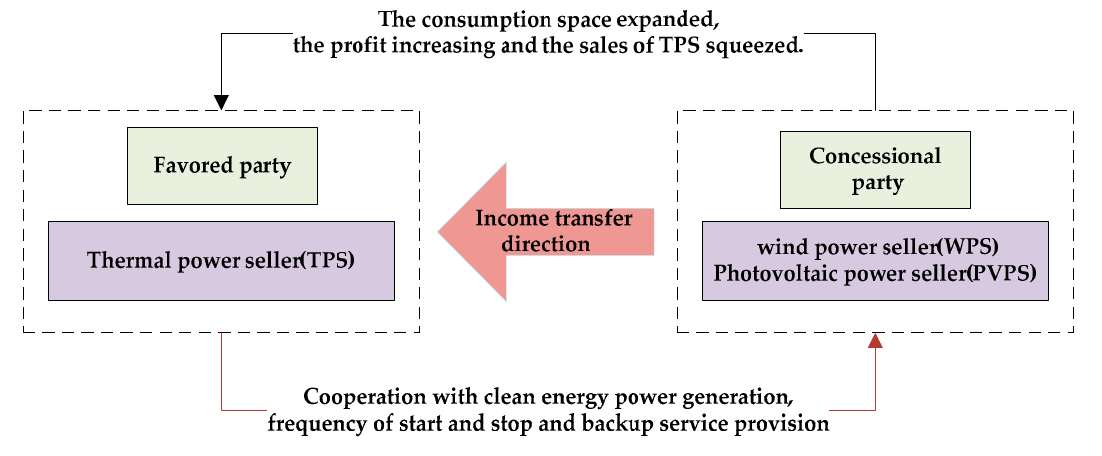
Figure 3. Role Positioning of the Alliance Participant.